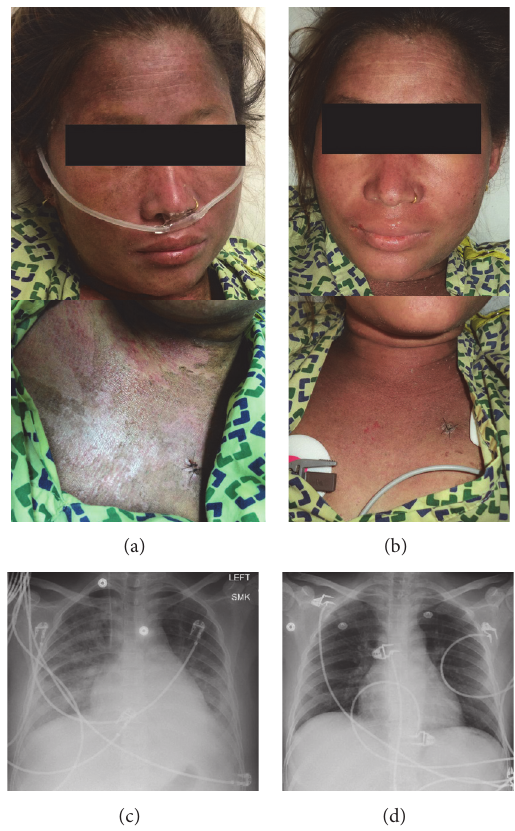
Figure 1: Photograph of the rash and chest X-ray at presentation and discharge. (a) Face and neck upon presentation. (b) Face and neck upon discharge. (c) Chest X-ray at presentation showing bilateral infiltrates. (d) Chest X-ray at discharge showing resolution of